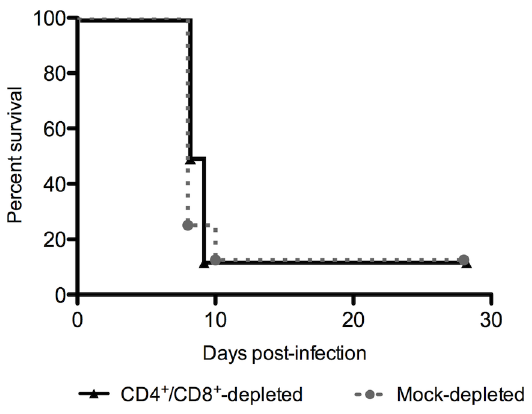
Figure 10. Depletion of T cells did not protect IN mice from death after D NSs virus IN infection. Mice were depleted of CD4 and CD8 T cells or mock-depleted on days -3 and -1 prior to infection, and inoculated with 1 6 10 4 TCID 50 D NSs virus IN. No significant difference in survival was observed between depleted and mock-depleted mice (n=10 mice per